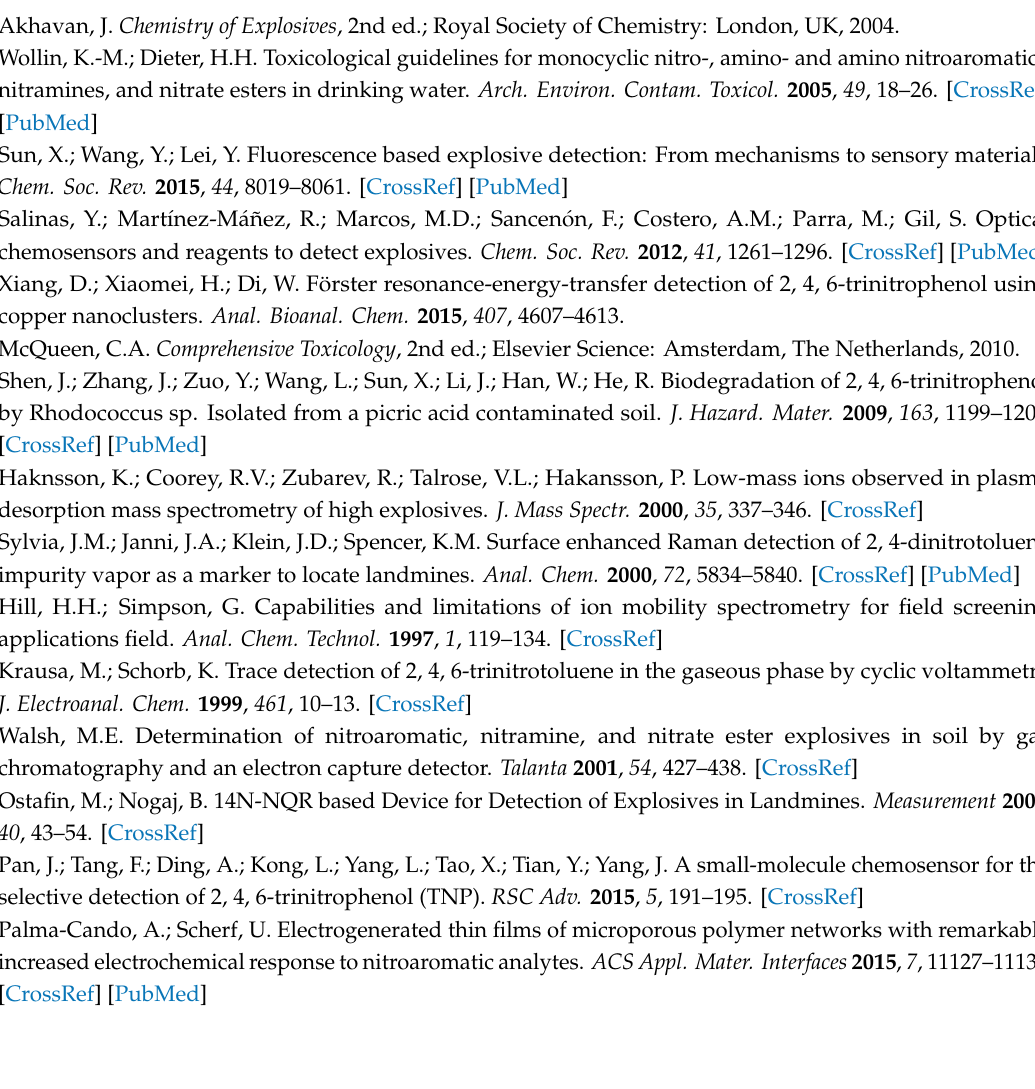
TNP ( A1 ), Figure S11: Competitive experimental spectra for each analyte ( λ ex = 365 nm), Figure S12: ( a ) UV-vis titration experiment of 1 in the presence of DNP ( A15 ) and ( b ) Fluorescence titration experiment of 1 in the presence of DNP ( A15 ) ( λ ex = 365 nm), Figure S13: Job’s plot obtained from fluorescence emission spectral data ( λ ex = 413 nm); G-analyte DNP ( A15 ) and H-receptor 1 , Figure S14: Benesi-Hildebrand plot of 1 for DNP ( A15 ) (G), Figure S15: Absorption intensity at 425 nm of 1 versus increasing concentration of DNP ( A15 ), Figure S16: ( a ) UV-vis titration experiment of 1 in the presence of A16 , A17 , A18 , A19 and ( b ) Fluorescence titration experiment of 1 in the presence of A16 , A17 , A18 , A19 ( λ ex = 365 nm), Table S1: The time resolved decay (tau) values of 1 , 1 : A1 (1 equivalents) and 1 : A2 (2 equivalents), Scheme S1, The aromatic ( A15 to A19 ) structures used in sensing